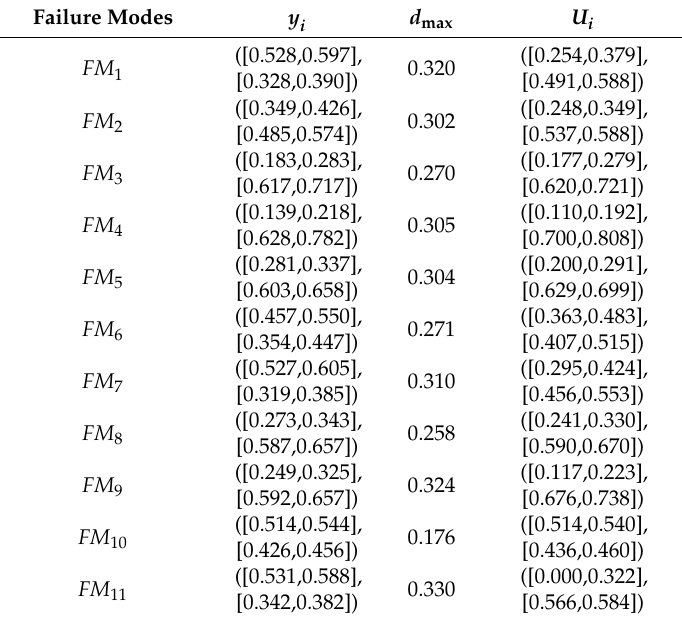
Table 7. Relevant parameters of the IVIF-MULTIMOORA method.